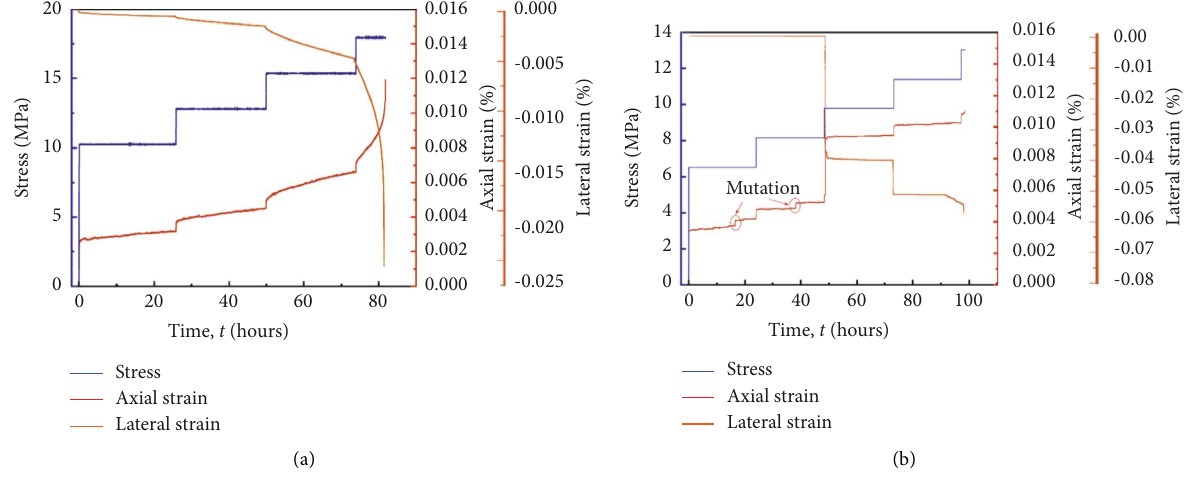
Figure 5: Creep strain curves by the step loading: (a) the natural sample and (b) the oil-eroded